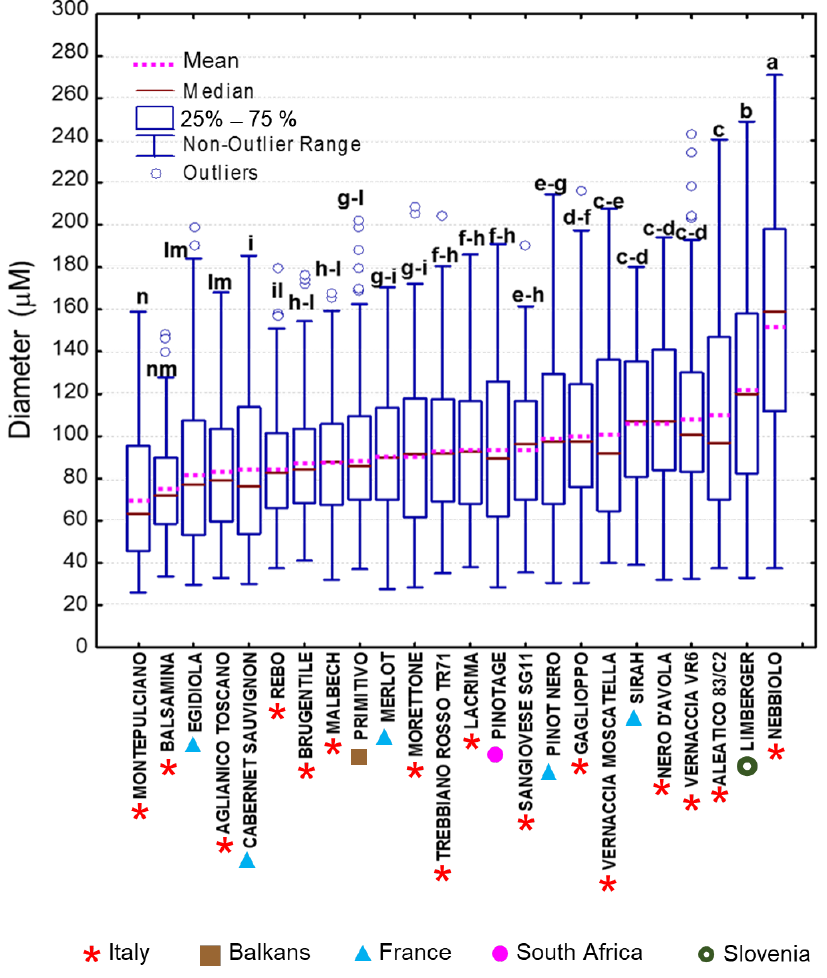
Figure 4. Box plot representing means of equivalent circle diameters measured in the 24 red-berried grapevine cultivars. The median and mean are represented by solid red and dotted pink lines, respectively. Top and bottom lines of the box correspond to the 25th and 75th percentiles of the data, respectively. Error bars represent the 10th and 90th percentiles. Circles represent outliers. Different letters above columns indicate significant differences between cultivars (Fisher’s tests; p ≤ 0.05). The geographic origin was added.